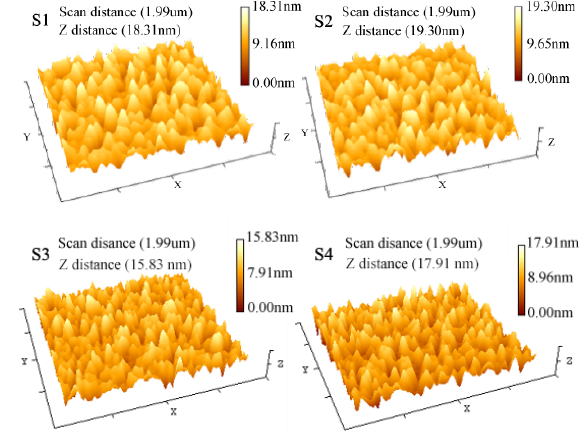
Fig. 2. AFM topographic 3D maps of